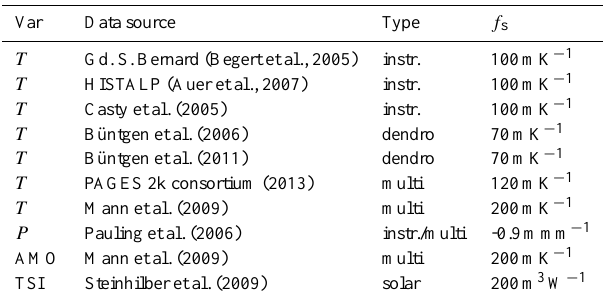
Table 3. ELA sensitivity factors f s used in the data comparisons in Figs. 2–4. Var Data